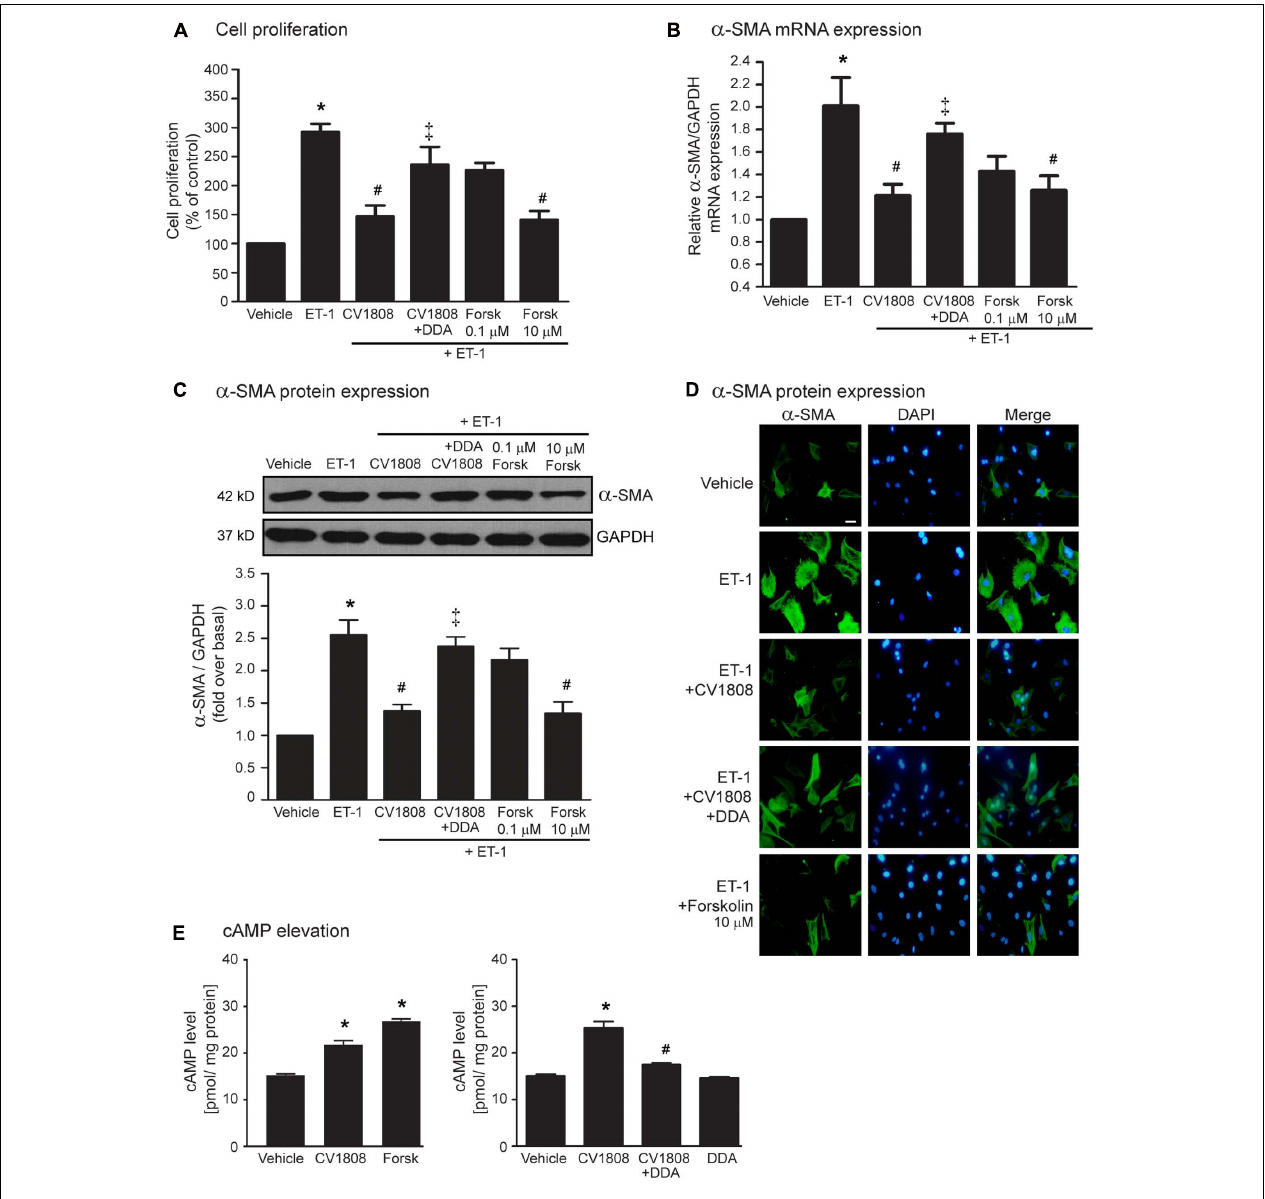
FIGURE 2 | CV1808 mediated-inhibition of ET-1-induced cell proliferation and α -SMA synthesis is cAMP dependent. (A–D) Cardiac fibroblasts were pretreated without or with 10 µ M DDA (AC inhibitor) for 1 h. After 1 h, cells were treated with vehicle (control), 10 µ M CV1808, or forskolin (Forsk; AC activator) for 1 h and further stimulated with 20 nM ET-1 for 12 h (B) or 24 h (A,C,D) at 37 ◦ C. (A) Cell proliferation was quantified by MTT assay. The data were expressed as the percentage relative to the non-treated group, and shown as mean ± SEM ( n = 4). ∗ P < 0.05 vs. vehicle; # P < 0.05 vs. ET-1; ‡ P < 0.05 vs. CV1808+ET-1. (B,C) Relative α -SMA mRNA (B) and protein (C) levels were quantified and shown as the mean ± SEM ( n = 4). ∗ P < 0.05 vs. vehicle; # P < 0.05 vs. ET-1; ‡ P < 0.05 vs. CV1808+ET-1. (D) Cells were incubated with anti- α -SMA antibody followed by goat anti-mouse antibody (Alexa Fluor 488). The α -SMA was visualized by fluorescent microscope. Cells were stained for α -SMA (green) and nuclear staining of nucleus with DAPI (blue). Bar, 10 µ m. (E) (Left) Cells were treated with 10 µ M CV1808, forskolin, or vehicle for 30 min. (Right) Cells were pretreated without or with 10 µ M DDA for 1 h. After 1 h, cells were treated with vehicle (DMSO), or 10 µ M CV1808 for 30 min. The cAMP levels were measured using cyclic AMP ELISA kit and shown as [pmol/ mg protein] ( n = 4). ∗ P < 0.05 vs. vehicle; # P < 0.05 vs.